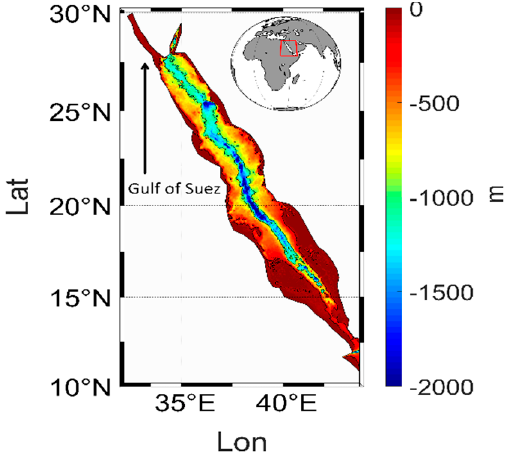
Figure 1. Map of the Red Sea basin associated with bathymetry in meters (m).